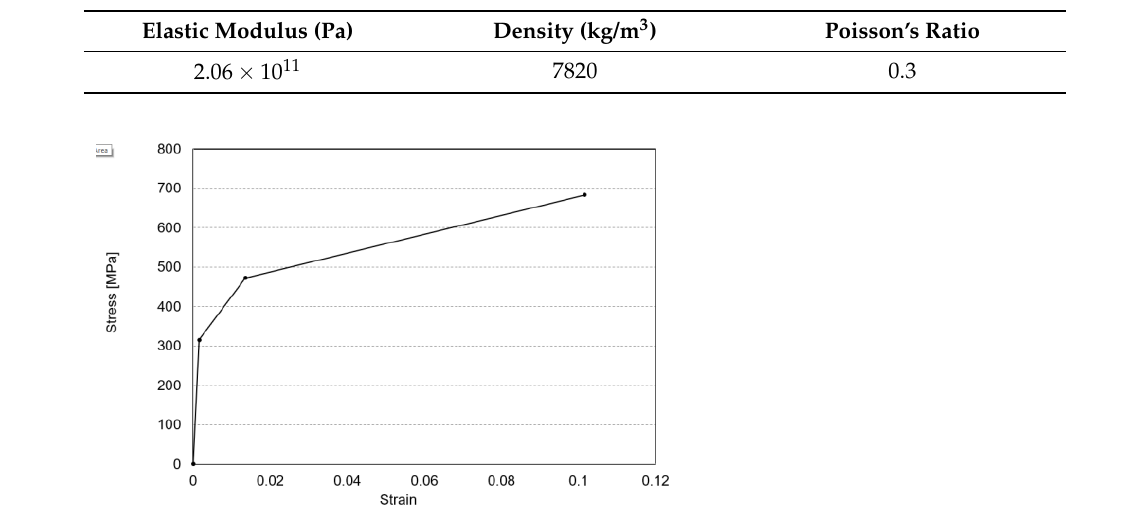
Figure 11. Stress vs. strain for steel plate.